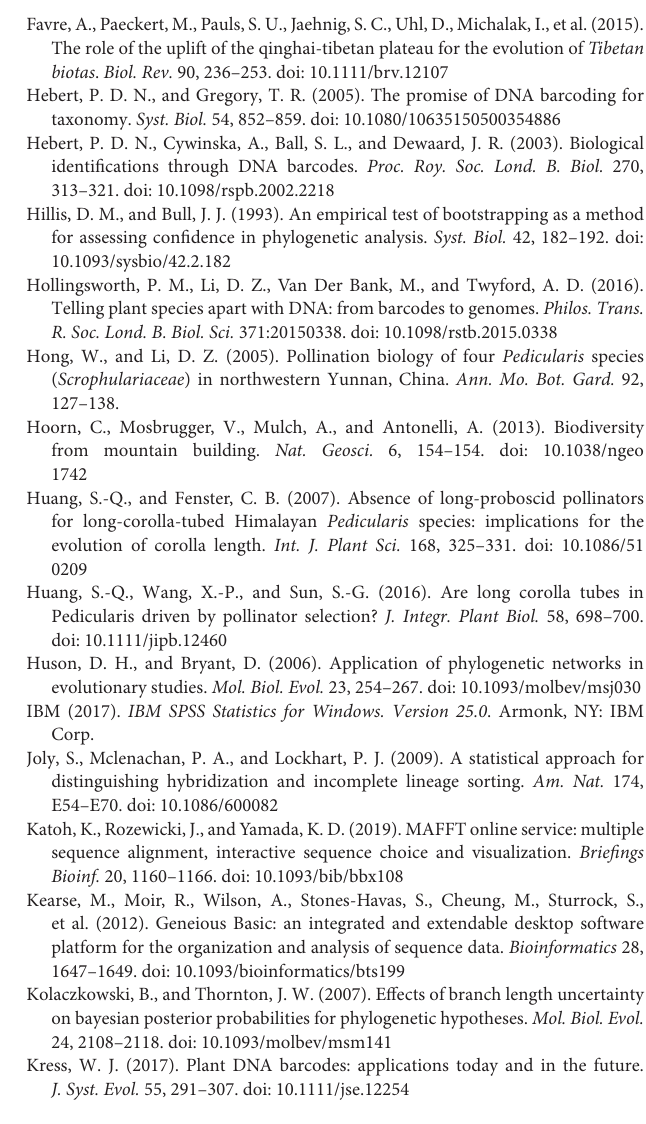
Supplementary Figure 1 | Maximum clade credibility tree of Pedicularis from BEAST divergence time analysis. The secondary calibration of the Orobanchaceae crown was constrained to 56 ± 10 Mya which was obtained from http://timetree.org/. The estimated age of nodes is presented above the branch. Node bars represent the 95% highest posterior density (HPD)